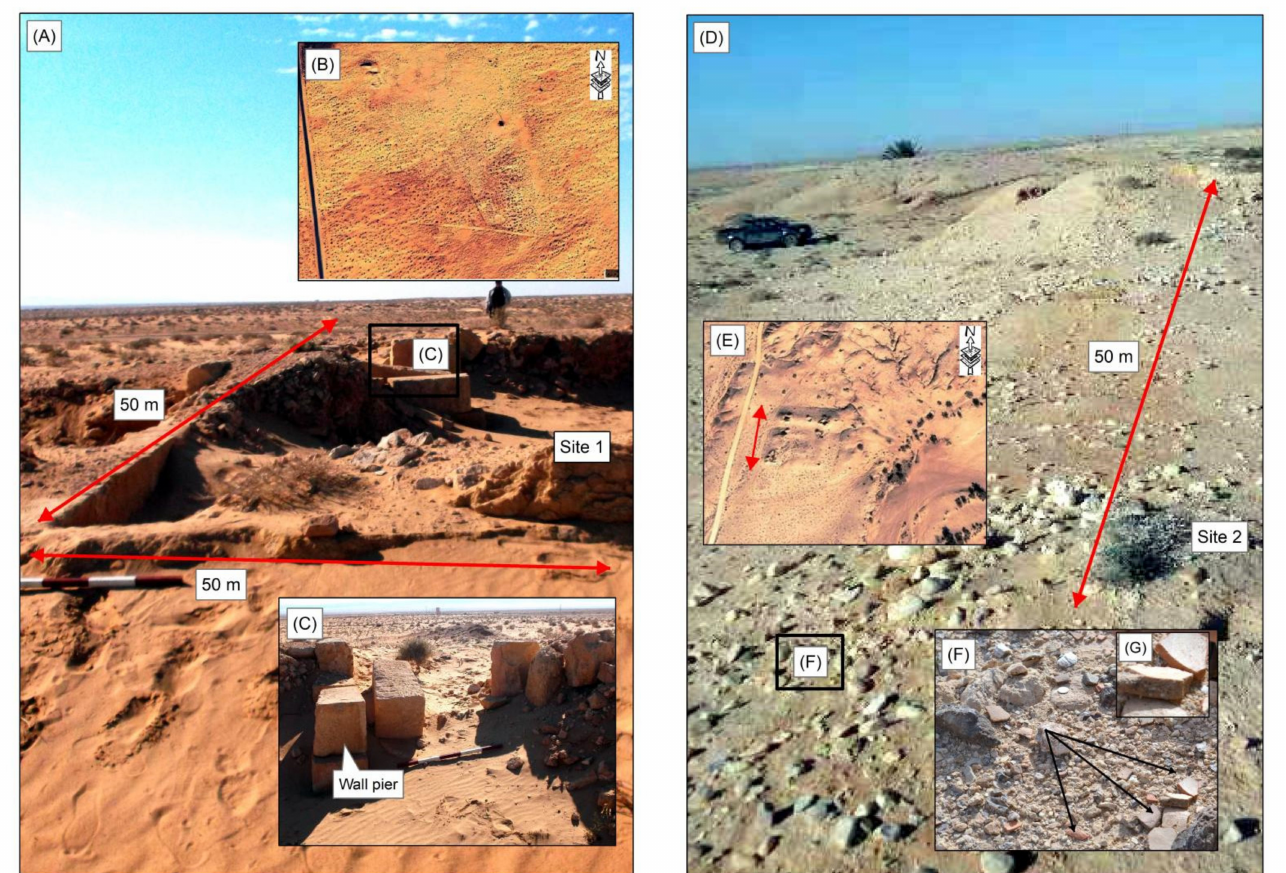
Figure 10. ( A , D ) Magnified views of site 1 and 2 with field photos of the wall remains; ( B , E ) Google Earth image of sites 1 and 2 from 2009 with detected changes due to looting; ( C ) photo of the northwestern the entrance of the fortress; ( F ) pottery fragments (the black box in G